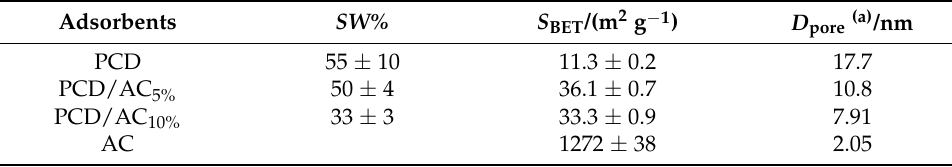
Table 2. Swelling degree and structural properties of the adsorbent materials.